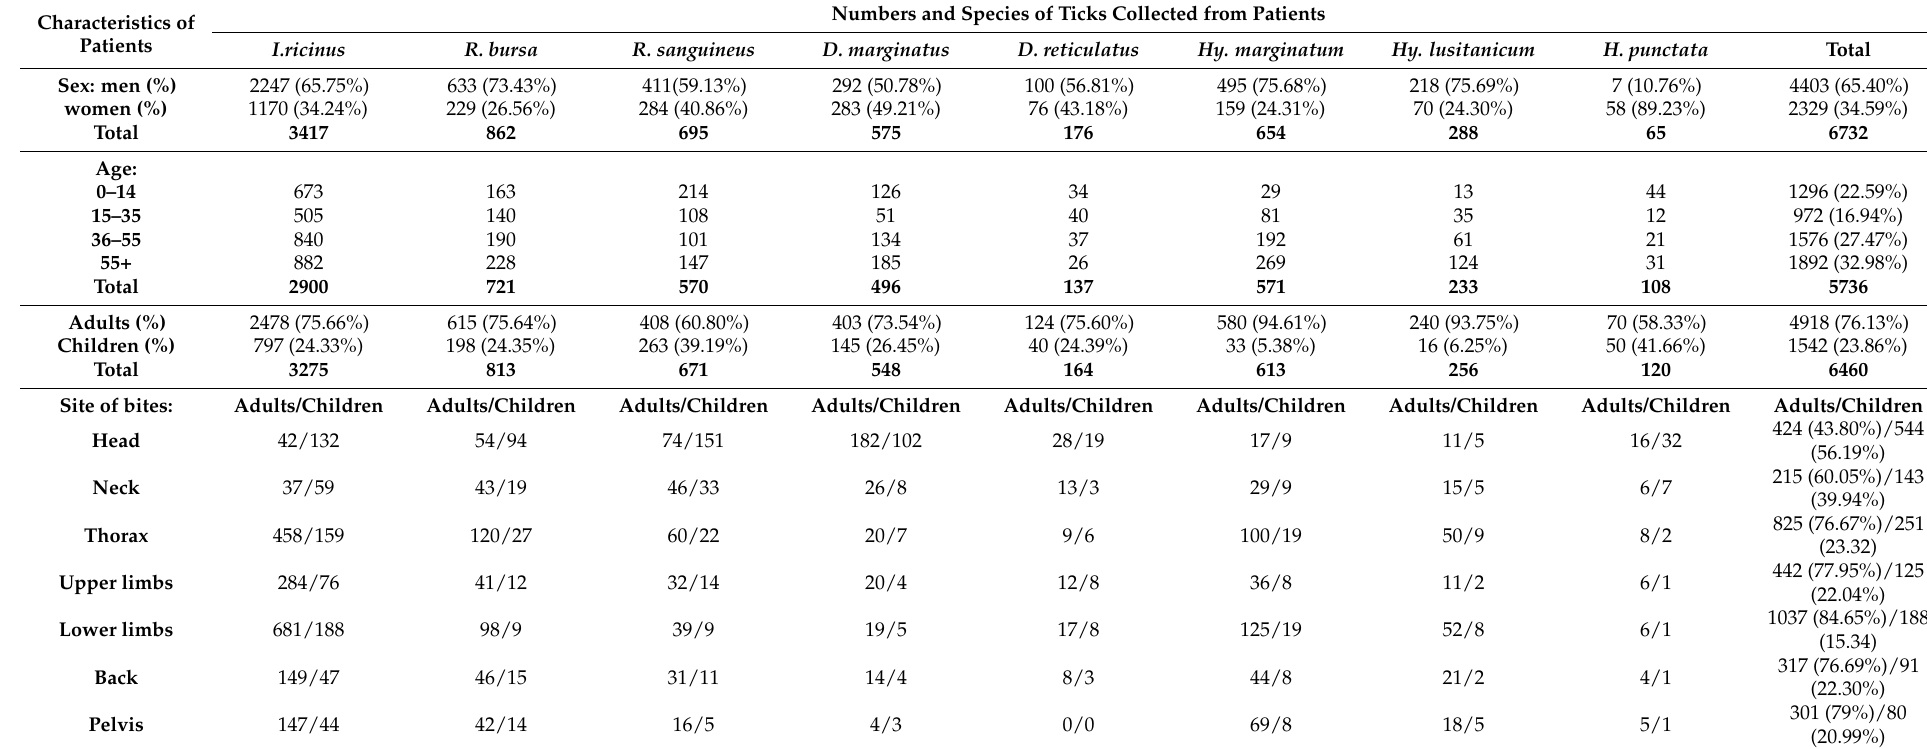
Table 2. Epidemiological characteristics of people bitten by ticks